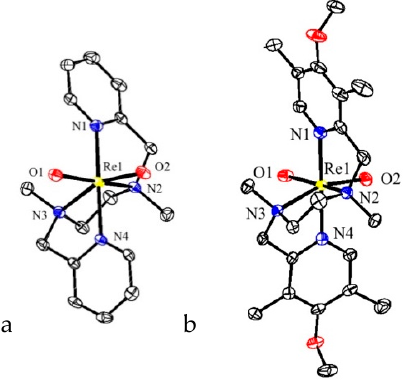
Figure 1. Molecular structures of ( a ). cis -[(BPMEN)ReO 2 ] + ( 2 ) and ( b ). cis -[(B mdm PMEN)ReO 2 ] + ( 3 ) in the crystal, drawn at the 50% probability level. Hydrogen atoms and the PF 6 counterions are omitted for clarity. For compound 3 , the cocrystallized methanol solvent molecule is omitted as well.